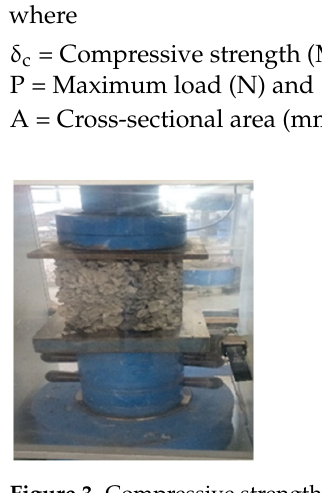
Figure 3. Compressive strength